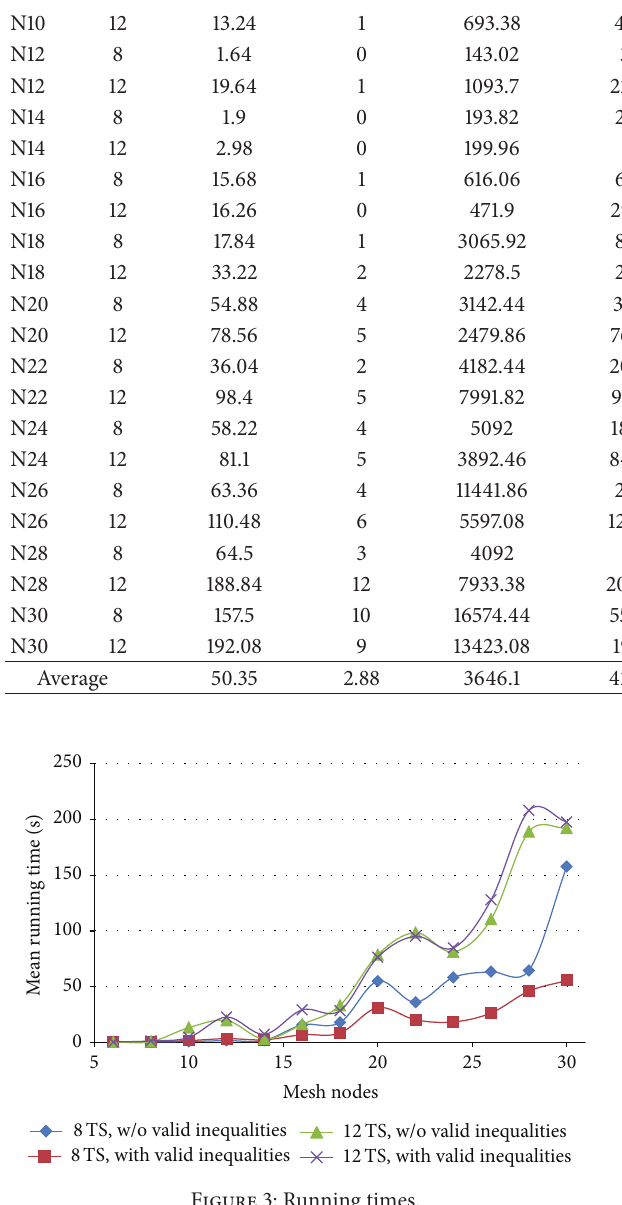
Figure 3: Running times. Figure 4: Fraction of improved test